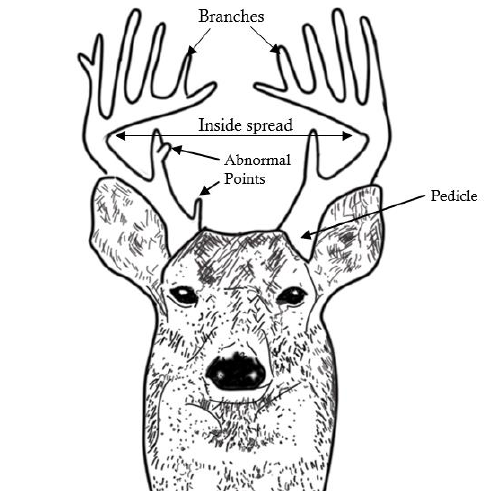
Figure 1. Antler anatomy (SCDNR,